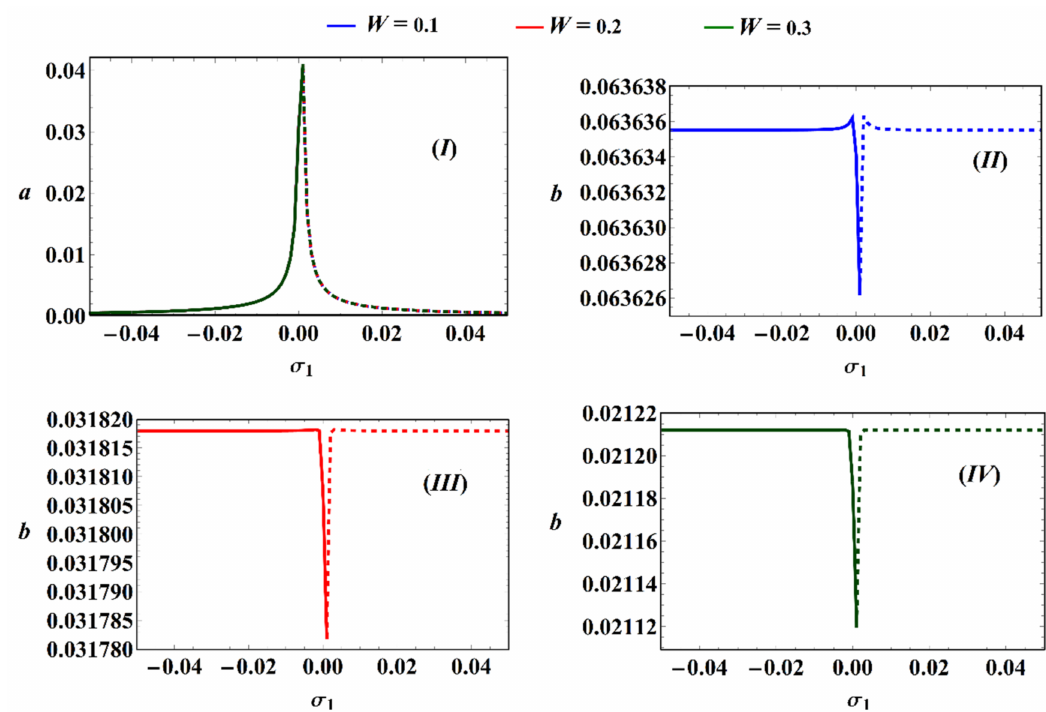
Figure 20. The frequency response at σ 2 = 0, c 1 = 0.001, and c 2 = 0.011 of: a ( σ 1 ) as seen in ( I ), and b ( σ 1 ) as shown in ( II ) at W = 0.1, ( III ) at W = 0.2, and ( IV ) at W = 0.3.